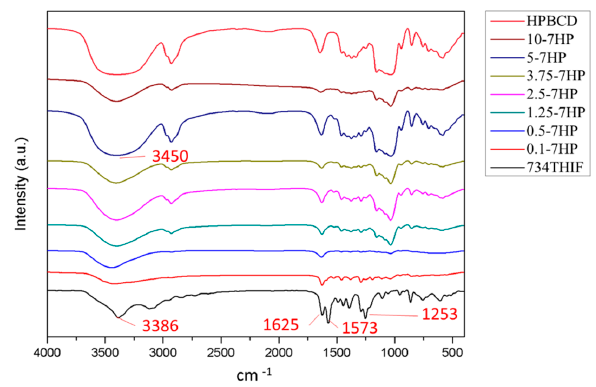
Figure 4. FT-IR spectra of 734THIF, HPBCD, and different ratios of 734HP.